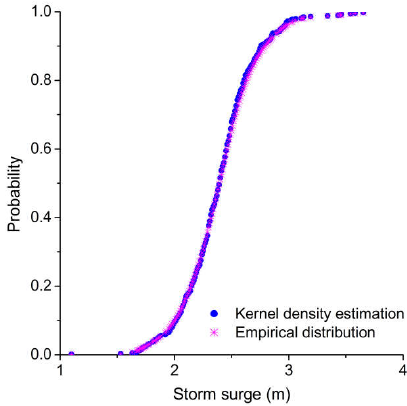
Figure 7. Cumulative probability distribution of storm surge.